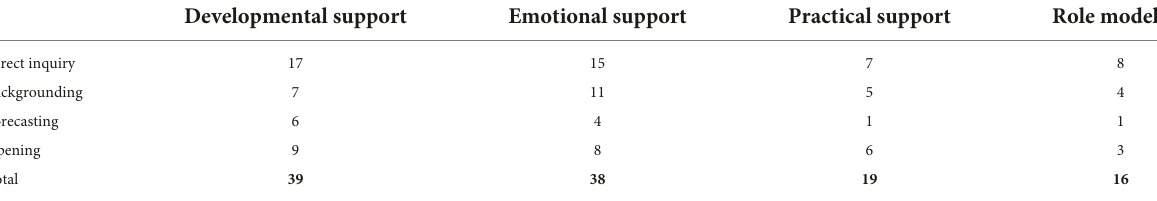
TABLE 8 Co-occurrences between learning leadership and feedback seeking